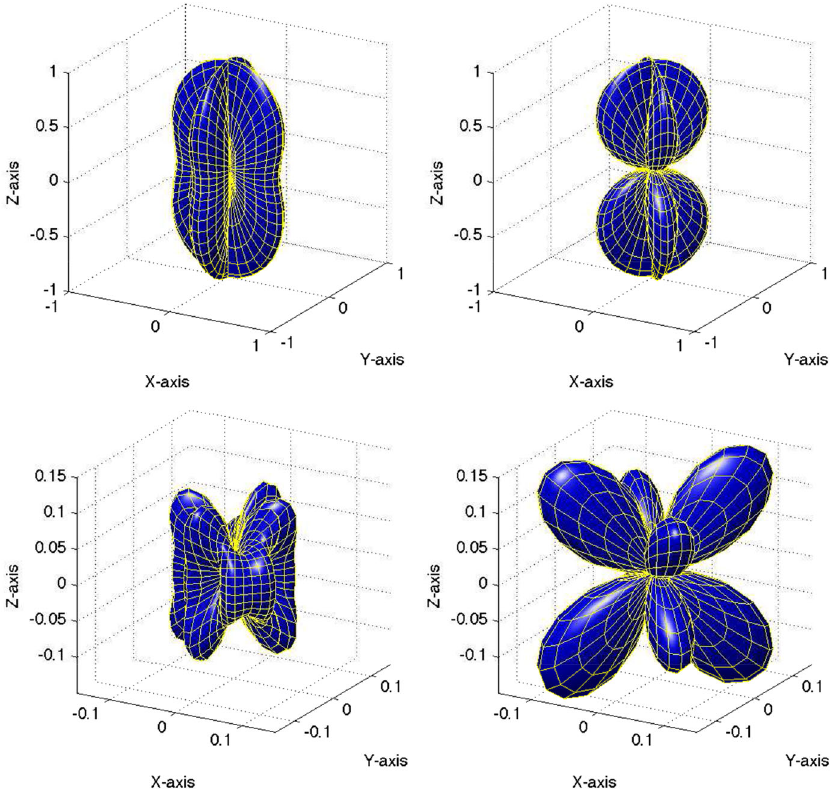
| and | R × | evaluated in strain strain